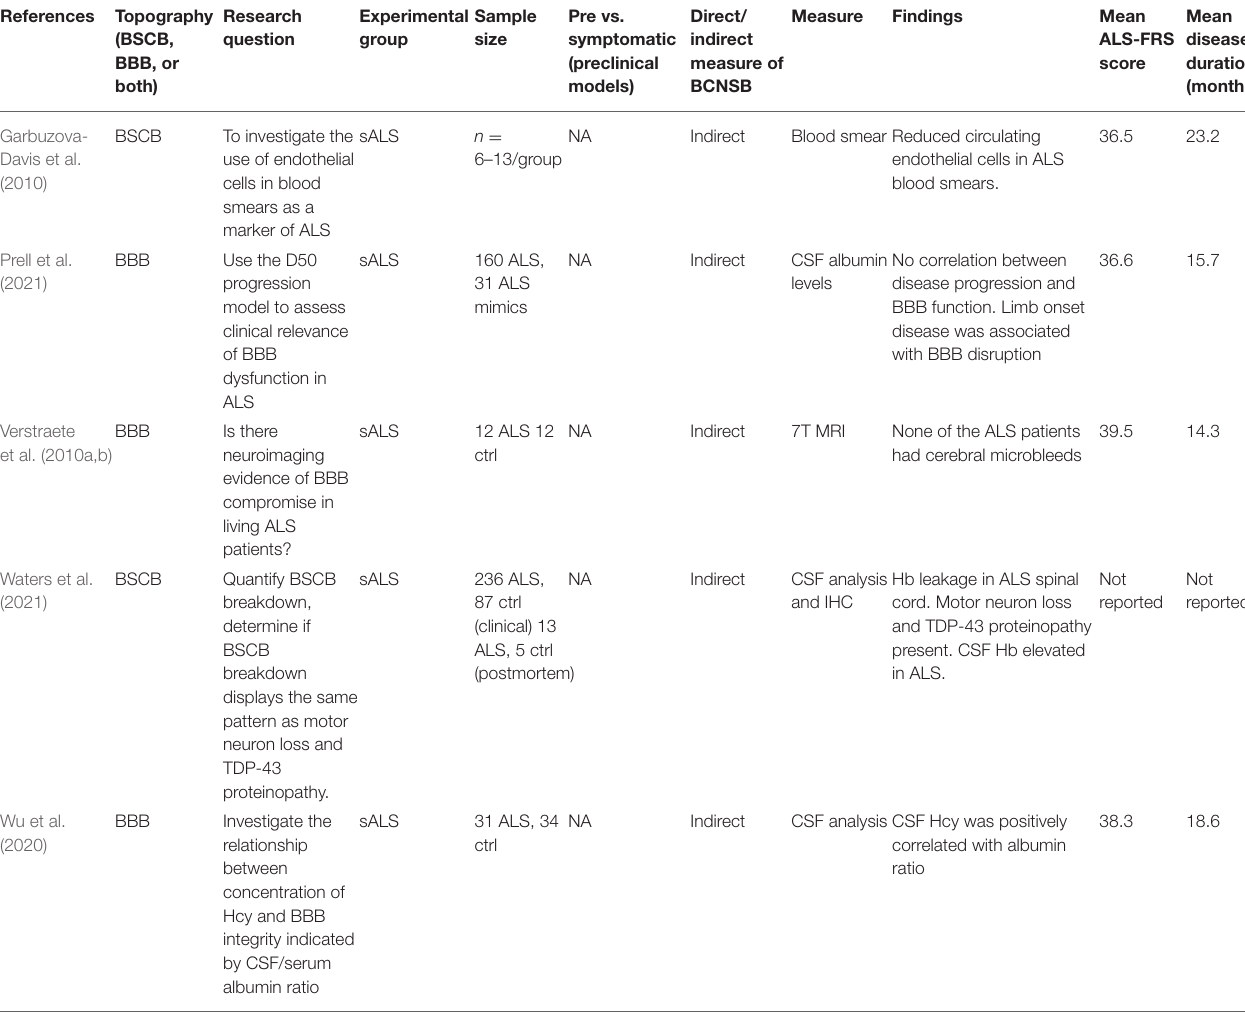
Experimental group